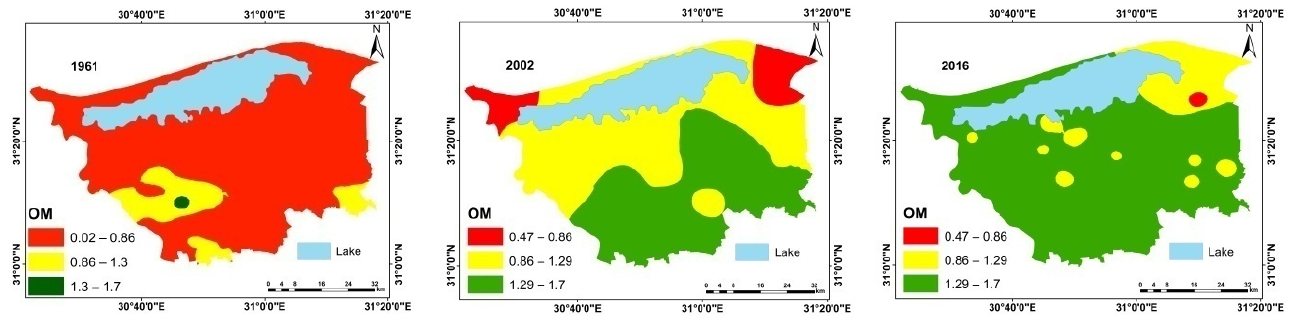
Figure 13. Organic matter content map in 1961, 2002, and 2016.